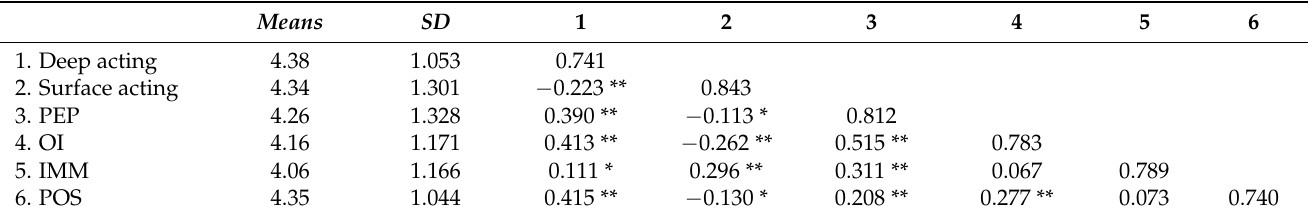
Table 2. Correlation matrix and